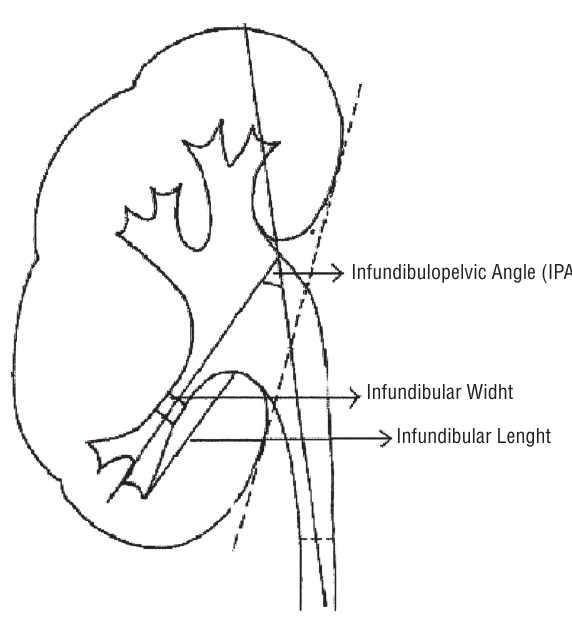
Figure 1 - El-Bahnasy defined infundibulopelvic angle as the inner angle between the ureteropelvic axis (A line connect- ing the central point of the pelvis opposite the margins of superior and inferior renal sinuses to the central point of the ureter opposite the lower kidney pole) and central axis of lower pole infundibulum.